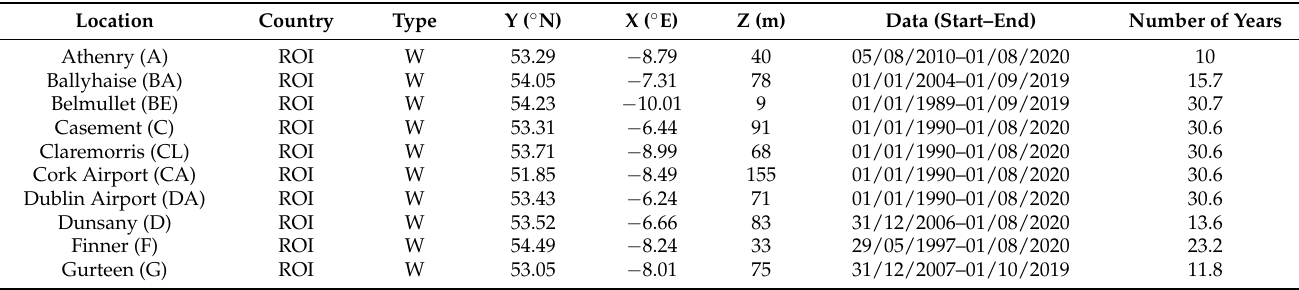
Figure 6. A map of Ireland with all known wind turbine parks in both the Republic of Ireland (ROI) and Northern Ireland (NI), marked. The 23 weather stations and the 8 rain chemistry stations used in this paper are also marked. Table 1. List of stations, country, station type (W—weather, C—rain chemistry), latitude (X), longitude (Y), sample collection height (add 10 m for wind data, Z) and period of time